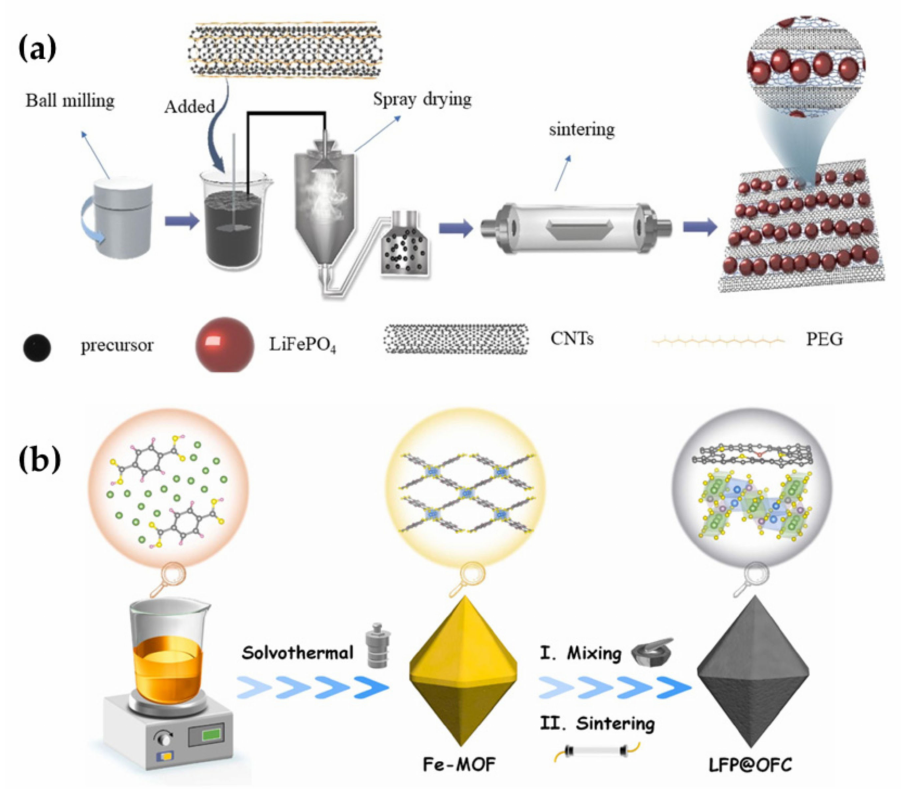
Figure 8. ( a ) Flowchart of LFP-C synthesis using a ball mill and spray drying (adapted with permis- sion from Ref. [74]. 2022 Elsevier). ( b ) Schematic depiction of solvothermal and sintering methods for preparing MOF-derived LFP-C matrix. (adapted with permission from Ref. [23]. 2022